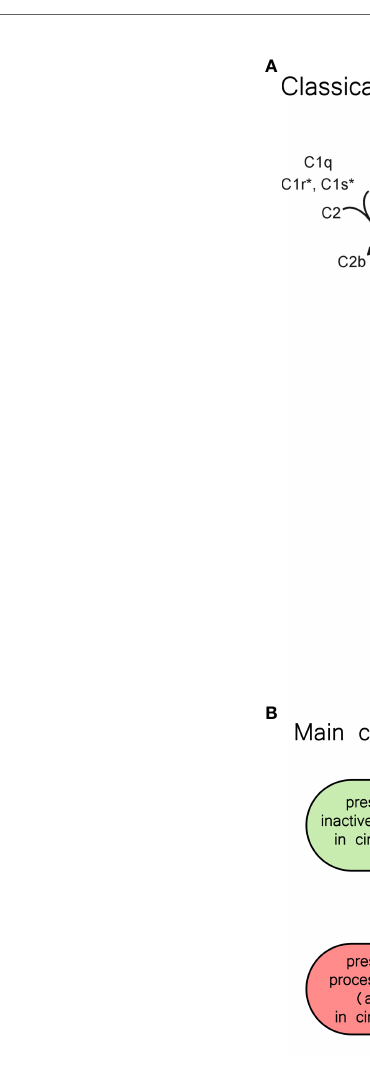
FIGURE 1 | The complement system and properties of its proteases. (A) Overview of the complement system. The three activation routes, the ampli fi cation loop, and the terminal pathway are described in the text, and this panel is intended to aid the reader as a guide. Asterisks indicate active proteases. (B) Categories of complement proteases by activation status. Green and red shading indicates the two main categories. Typical serine proteases are synthesized in the proenzyme form, and remain proenzymic until a they are cleaved into the active form following a trigger. In the complement system C1r, C1s, MASP-1, and MASP-2 fall into this category. Among these, C1r and MASP-1 can ef fi ciently autoactivate. MASP-3, FD, and FI, are present predominantly (or completely) in the active form in the blood, however they have very narrow substrate speci fi cities. C2 and FB are special cases, because they gain a transient activity following cleavage as parts of the C4bC2a, or the C3bBb